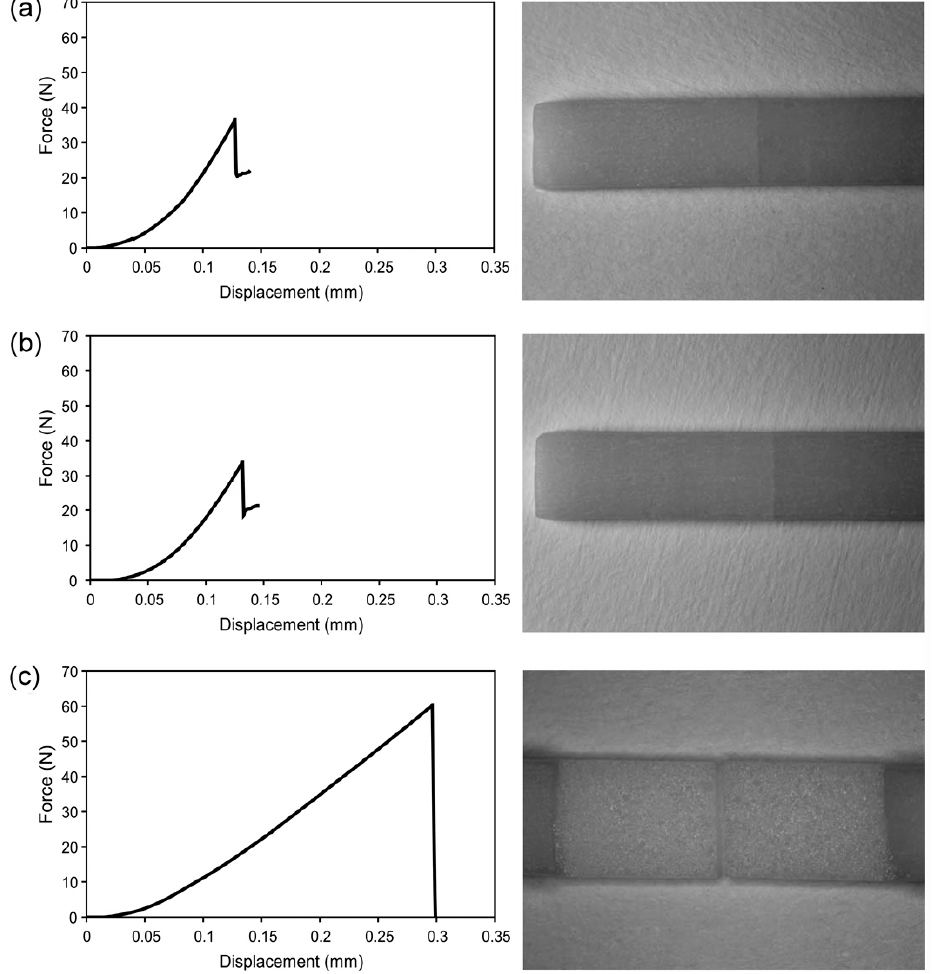
Figure 2. Force-displacement graphs during three-point flexural strength test ( Left ) and optical images of the corresponding fractured specimens ( Right ; 8× ( a , b ) and 10× ( c )). ( a ): A specimen of group NL showed cracking; ( b ): A specimen of group CL showed cracking; and ( c ): A specimen of group EL3 showed catastrophic failure. See Table 4 for detailed failure mode results. Table 4. Flexural strength, Weibull distribution values, and failure mode distribution for each group ( n = 15).